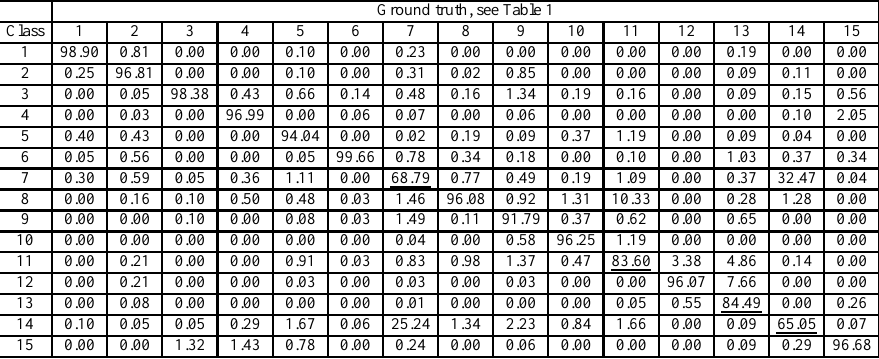
Table 4: Confusion matrix of the FG classification on Salinas benchmark (MNF 20 features, alphabet size: 100, feature median 5 × 5 filtering). Overall accuracy=85.3217, Kappa=0.8358 Percentages are given for an easier interpretation. Ground truth, see Table